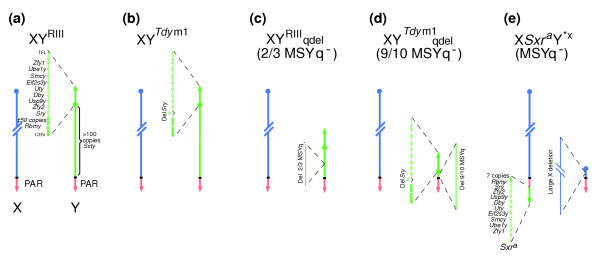
Sex chromosome complements of the mice with MSYq deficiencies and relevant control mice. (a) XYRIII control, illustrating the previously documented male specific gene content of the mouse Y chromosome. The short arm (shown expanded) carries seven single copy genes, one duplicated gene (Zfy), and multiple copies of Rbmy. MSYq carries multiple copies of the Ssty gene family. (b) XYTdym1 control. This male has a normal Y gene complement except that a 11 kb deletion has removed the testis determinant Sry; the Sry deletion is complemented by an Sry transgene located on an autosome. (c) The variant YRIIIqdel has a deletion removing about two-thirds of MSYq. (d) The variant YTdym1qdel has a large deletion removing about nine-tenths of MSYq, together with the small 11 kb deletion removing Sry (complemented by an Sry transgene). (e) XSxraY* X mice are male because of the presence of the YRIII short arm derived, sex reversal factor Sxra attached distal to the X pseudo-autosomal region (PAR). Sxra comprises most of the Y short arm except for a substantial reduction in copies of Rbmy. The Y* X chromosome is in effect an X chromosome with a deletion from just proximal to Amel (close to the X PAR boundary) to within the DXHXF34 sequence cluster adjacent to the X centromere. It provides a second PAR, which is essential in order to avoid meiotic arrest. CEN, centromere; kb, kilobase; TEL, telomere.